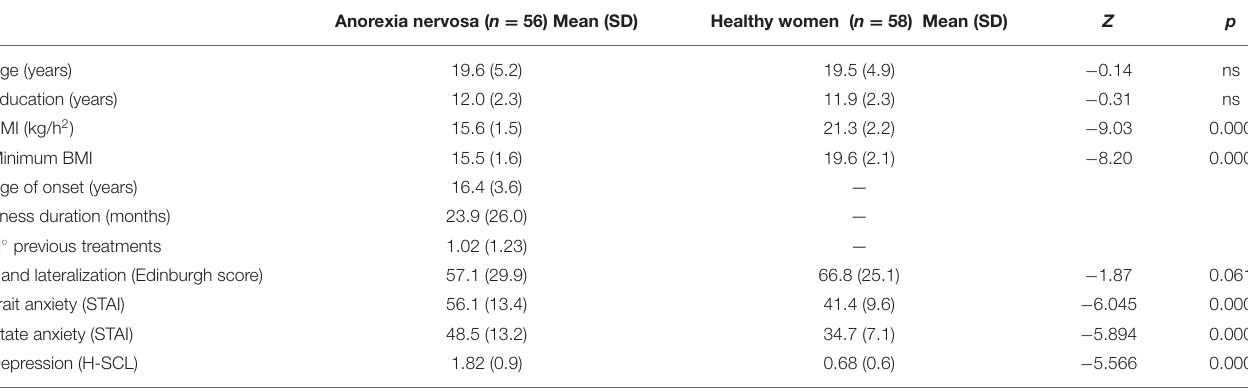
TABLE 1 | Clinical and general characteristics of patients (at admission) and controls.